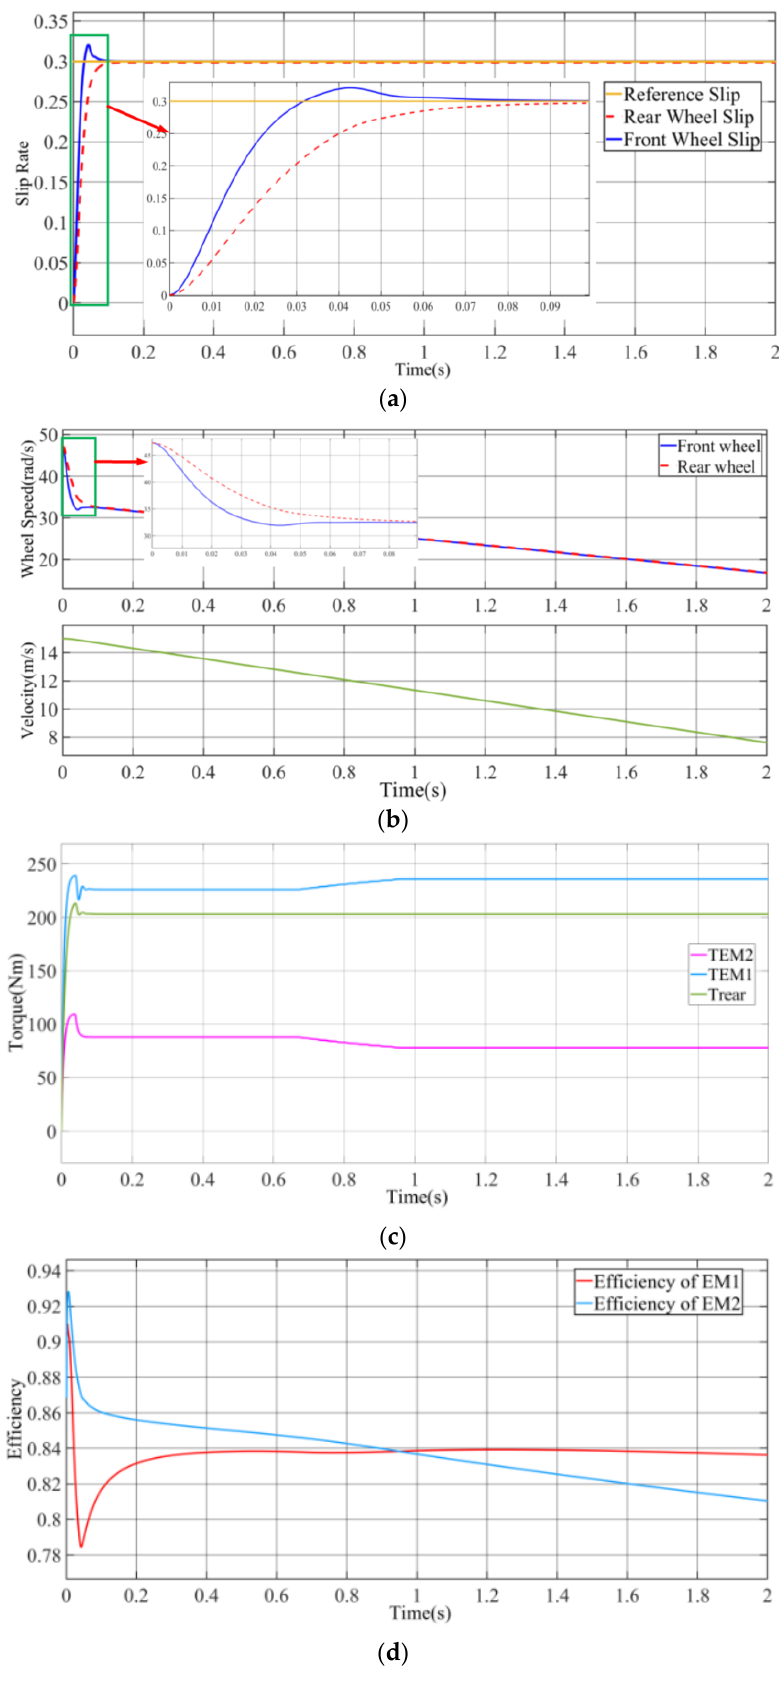
Figure 13. Braking performance in DMB: ( a ) slip rate variation; ( b ) vehicle speed and wheel speed variation; ( c ) braking torque variation; ( d ) motor efficiency variation.